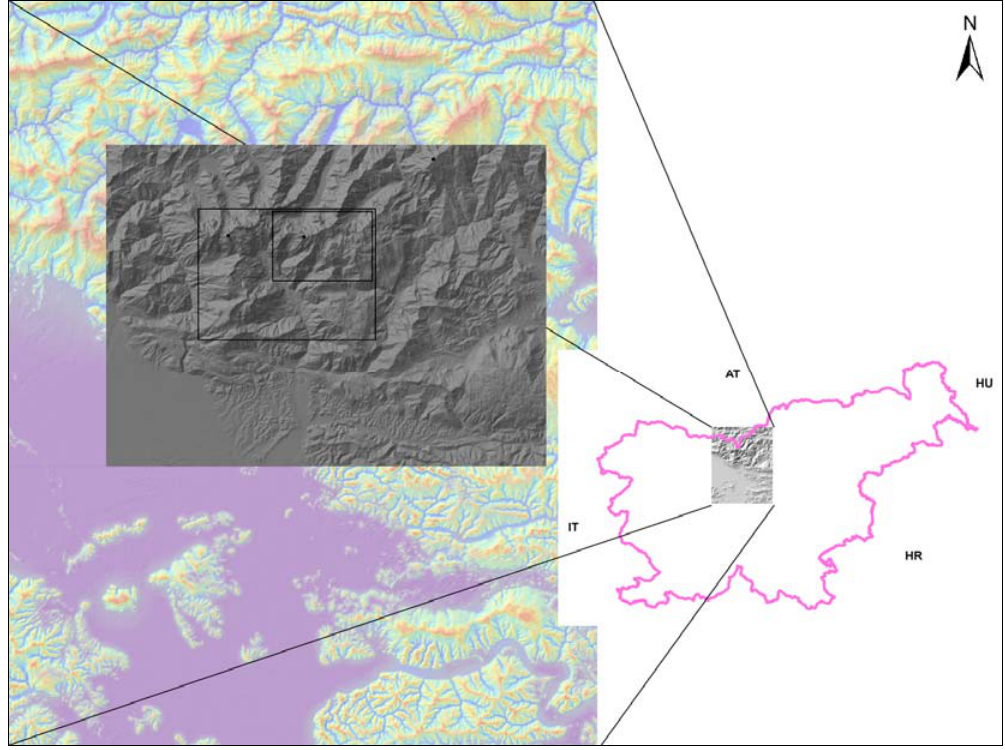
Figure 7. The case study area: the Kamnik Alps in Slovenia, with a primary area of dimensions 30 km × 20 km (dark grey) that reflect the areas for the Figures 3, 4, 10 and 11. The two additional frames illustrate zoom-in areas for the Figures 6 (13 km × 9.5 km), and 9 (8 km × 6 km). The three black dots in the primary area represent the detected global